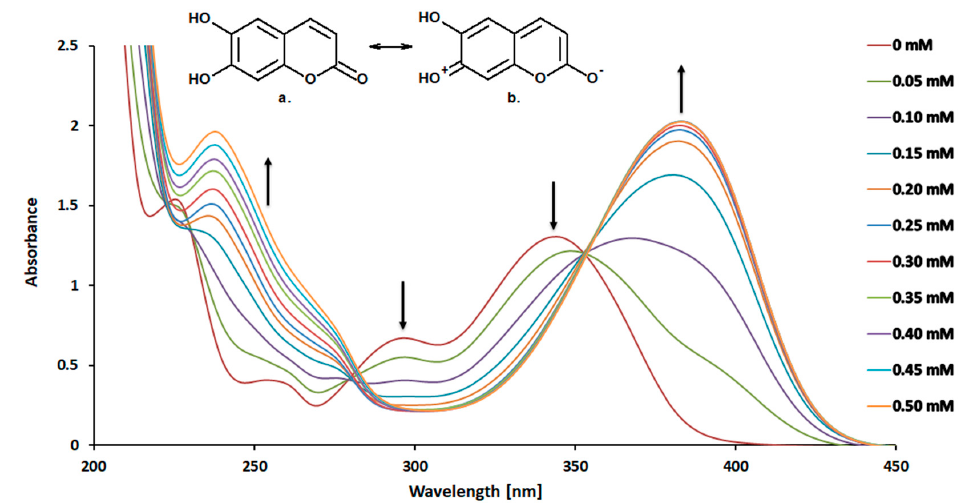
Figure 1. Absorption spectra of 6,7-dihydroxycoumarin (0.10 mM) in the presence of increasing concentrations (0–0.50 mM) of 4-amino-TEMPO in water at 25 °C. Inset presents the structures of two tautomers of 6,7-dihydroxycoumarin.